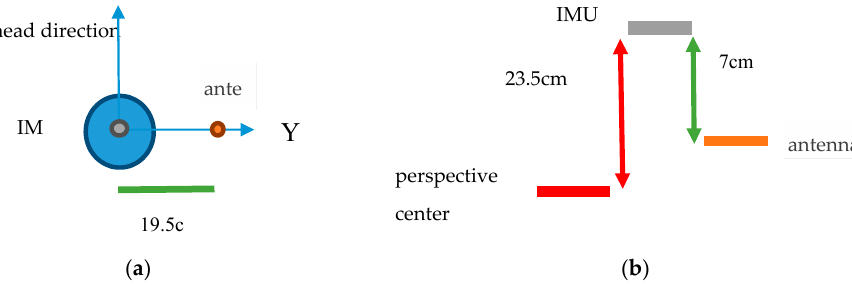
Figure 10. The offset illustration between IMU center and the antenna center. ( a ) Top view; ( b ) Side view.